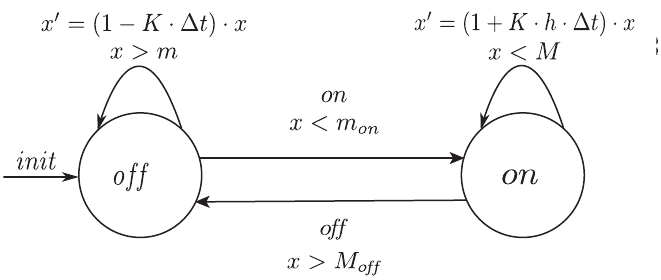
Figure 2. Inhomogeneous linear algebraic hybrid system (ILAHS) of a